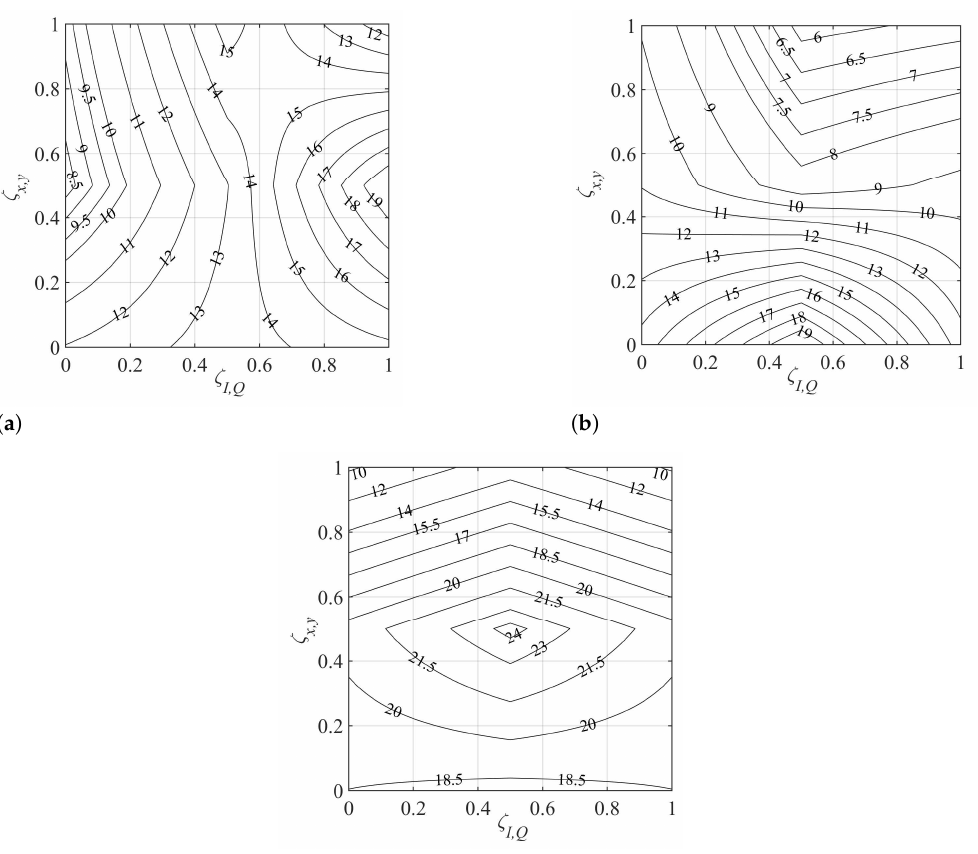
Figure 8. Unbalancing parameter for different pairs ( L B , L C ) and quasi-homogeneous WC-MCF (cid:0) ∆ (cid:1) β c, mn = − 701rad·m − 1 : ( a ) L B = 10m, L C = 10m, ( b ) L B = 10m, L C = 1m, and ( c ) L B = 0.1m, L C =